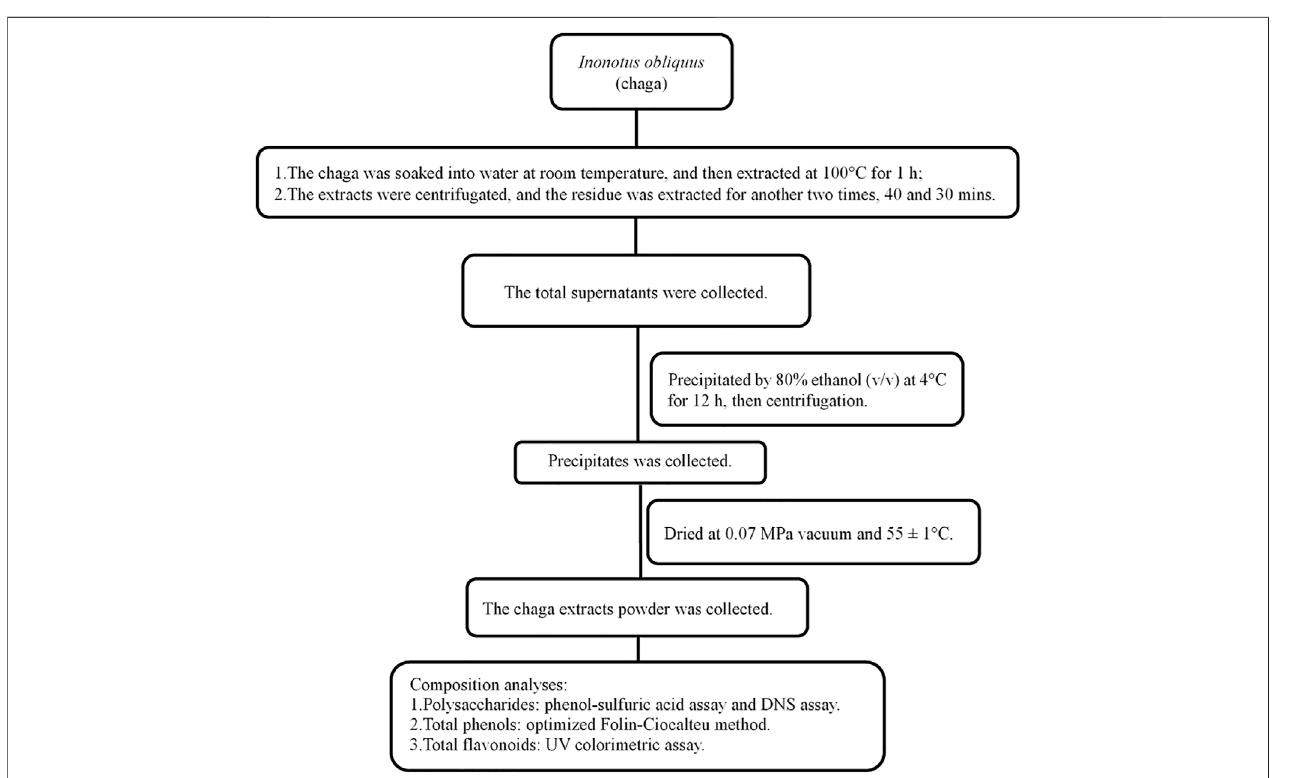
FIGURE 1 | Flowchart of Inonotus obliquus extracts and composition analyses. DNS, dinitrosalicylic acid.